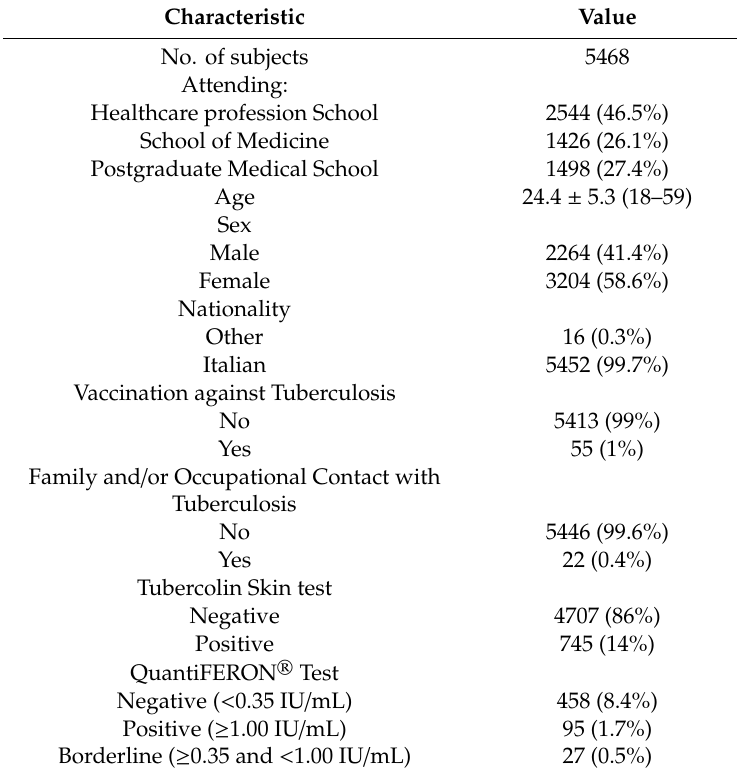
Table 1. Demographics of the 5468 subjects